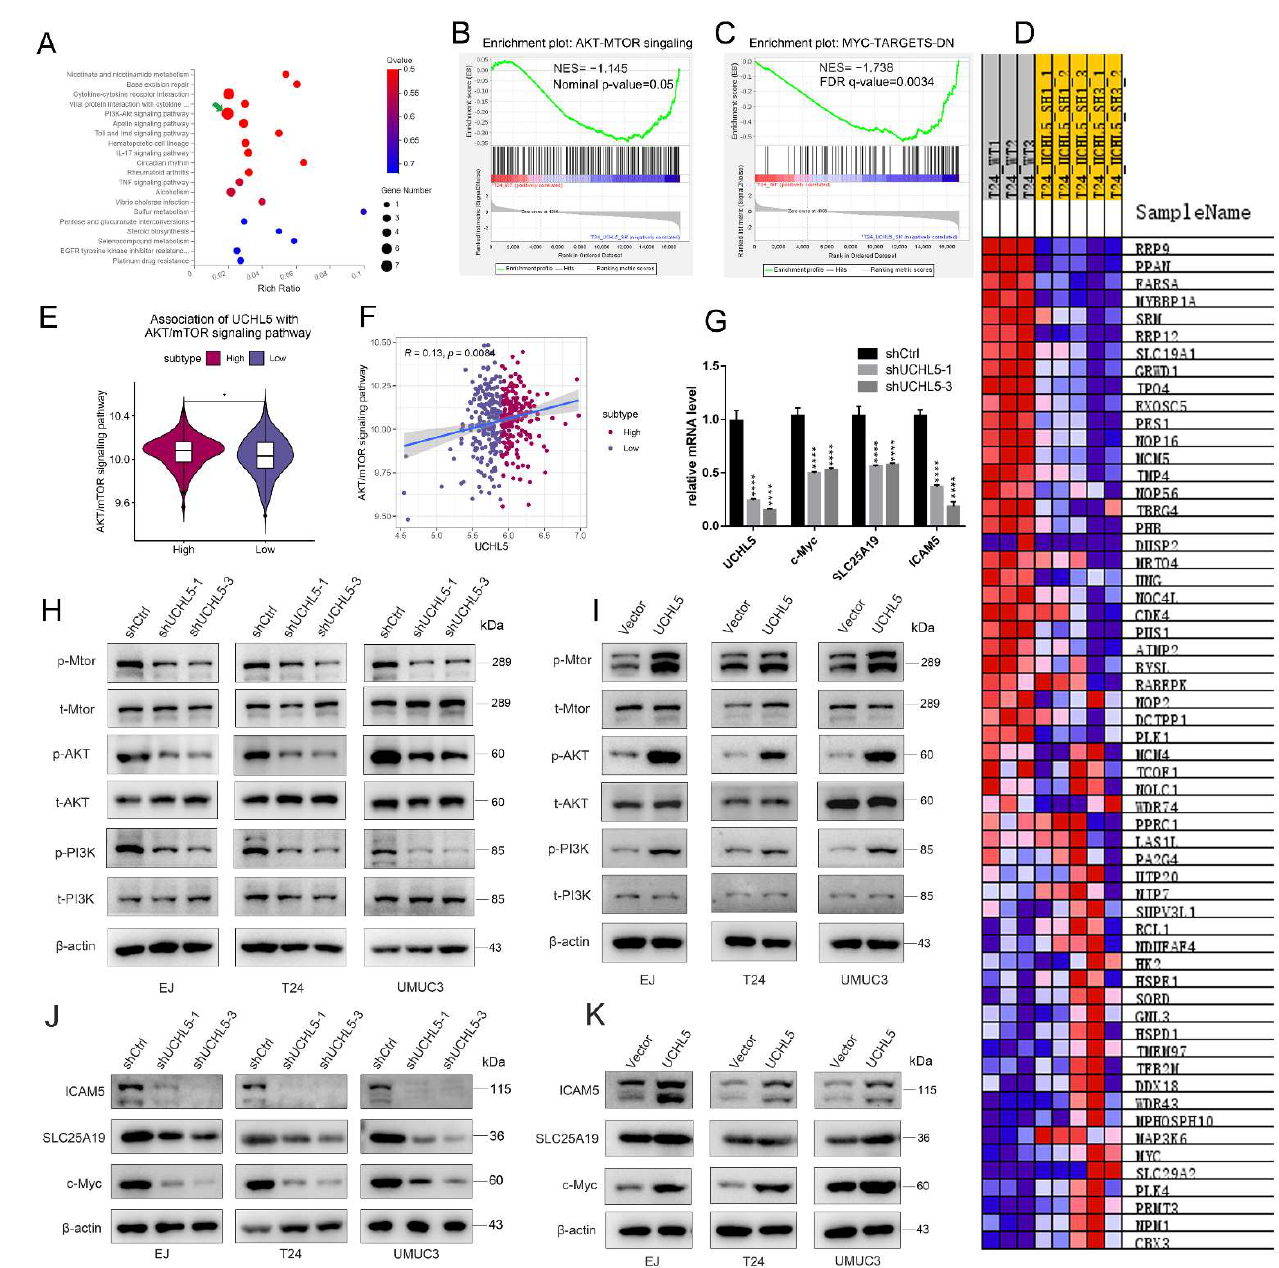
Figure 4. Knockdown of UCHL5 results in inactivation of the AKT/mTOR signaling pathway and contributes to decreased c-Myc, SLC25A19, and ICAM5 expression. ( A ) KEGG pathway enrichment analysis was used to assess RNA-Seq data containing shControl and shUCHL5 bladder cancer cells. ( B , C ) GSEA identified enrichment of AKT/mTOR signaling pathway and c-Myc gene sets. ( D ) Heat map of the differential expressed genes. ( E ) The difference in AKT/mTOR signaling pathway scores was defined using ssGSEA between the UCHL5 high- and UCHL5 low-expression groups. ( F ) The association of UCHL5 expression and AKT/mTOR signaling pathway score. ( G ) qRT-PCR determination of the mRNA levels of c-Myc, SLC25A19, and ICAM5 in bladder cancer cells transfected with shControl or shUCHL5. ( H – K ) Protein levels of the AKT/mTOR signal pathway proteins (t-PI3K, p-PI3K, t-AKT, p-AKT, t-mTOR, and p-mTOR), c-Myc, SLC25A19, and ICAM5 in UCHL5 silenced and overexpressed bladder cancer cells shown by Western blotting. β-Actin is used as the loading control. Values are shown as mean ± SD. * p < 0.05 and **** p < 0.0001 compared with controls.